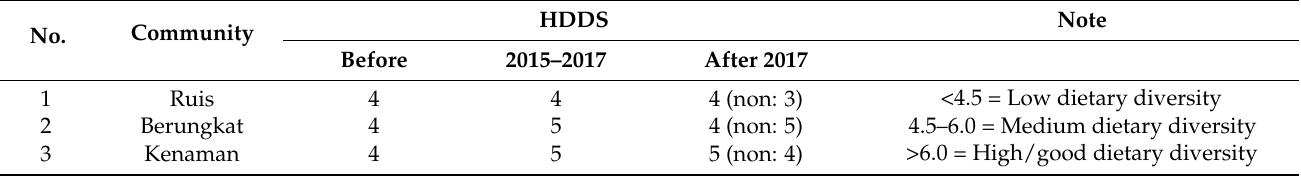
Table 13. Household dietary diversity score before and after KMP